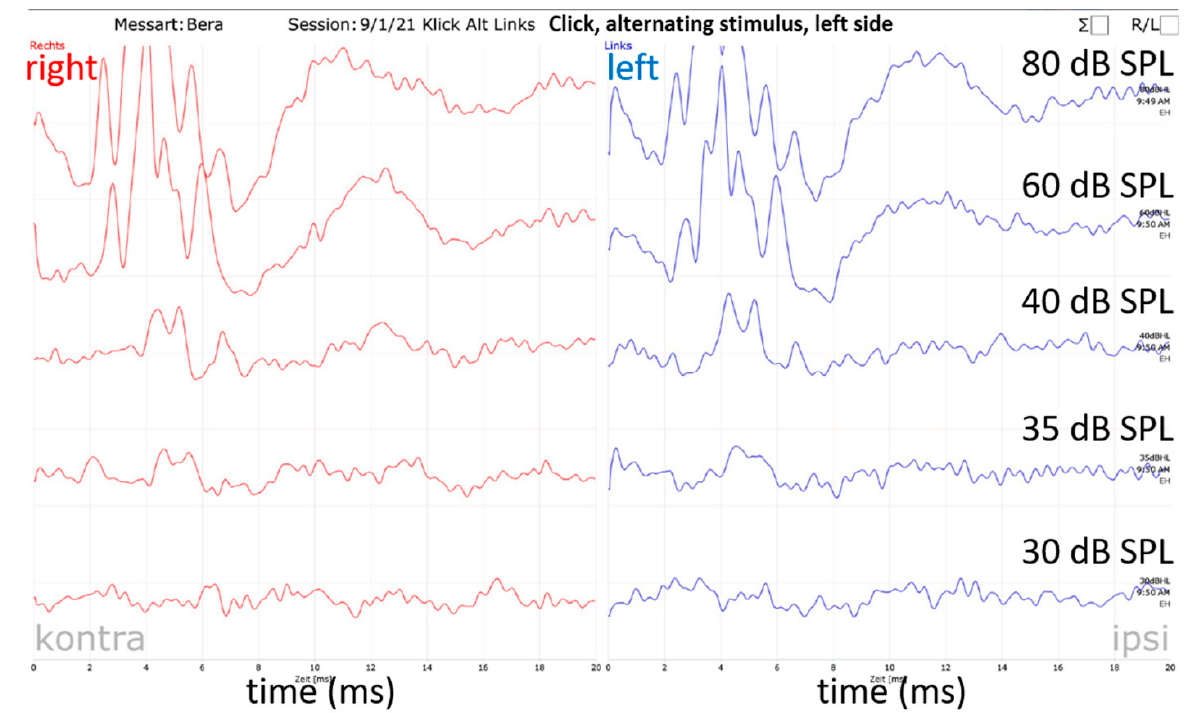
Figure 3. Hearing threshold determination. The visual hearing threshold determination exemplified by a naïve (d − 7) click measurement of the left side. It is a printout of the software’s evaluation file. Blue curves show the left-side recordings (stimulated side) and red curves the right-side recordings. Since there is no clear ABR signal on the left side below 35 dB, the hearing threshold was set at 35 dB SPL. Table 1. Overview of the time points and scope of the ABR measurements for implanted and con ‐ tralateral ears. Frequency ‐ specific measurements included the frequencies 500 Hz, 1, 2, 4, 8, 16, 32, and 40 kHz.